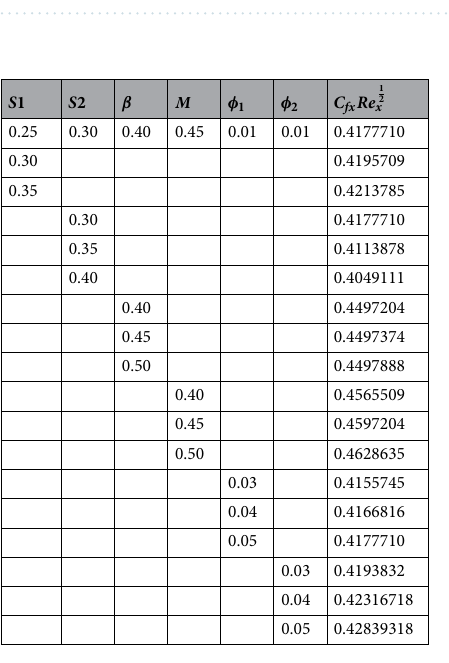
1 µ hnf 2 f ′′ ( 0 ) + β xg ′′ ( 0 ) x = µ nf (cid:31)